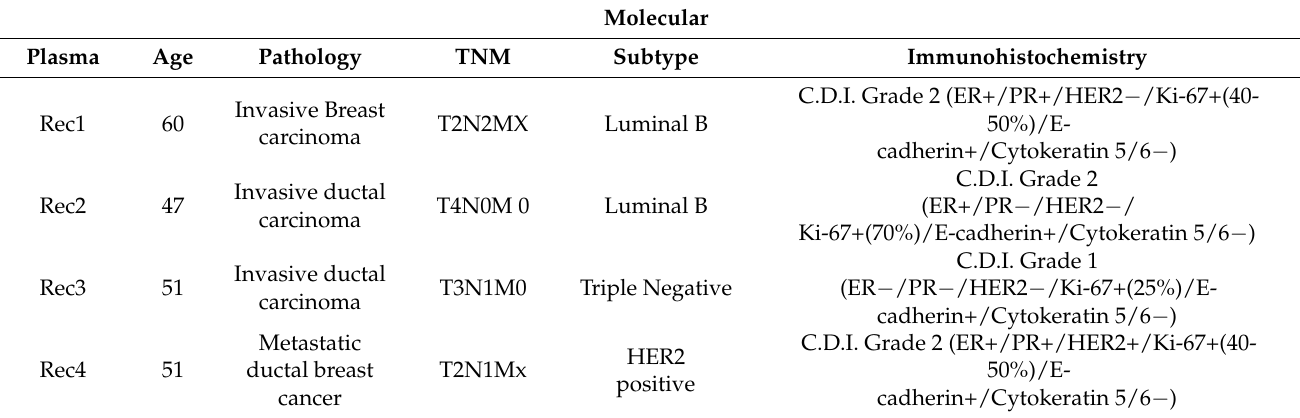
Table 2. Histopathological and clinical data of women with BC followed-up with disease